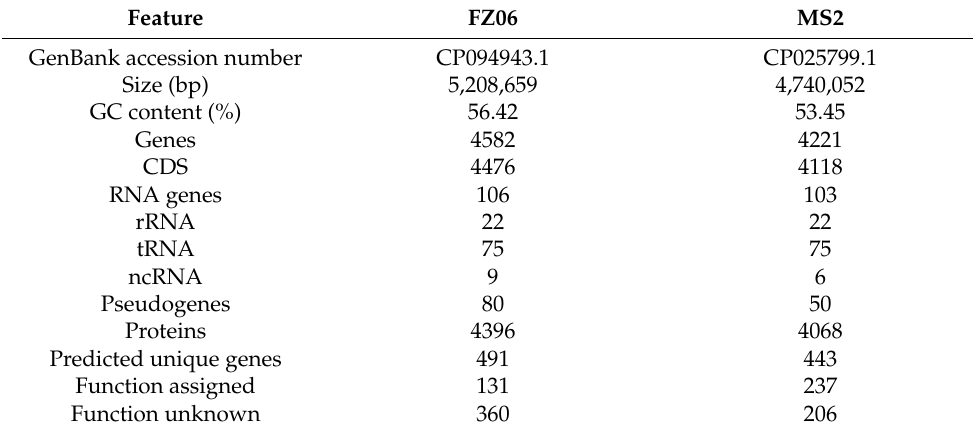
Table 2. Genomic features of strains FZ06 and